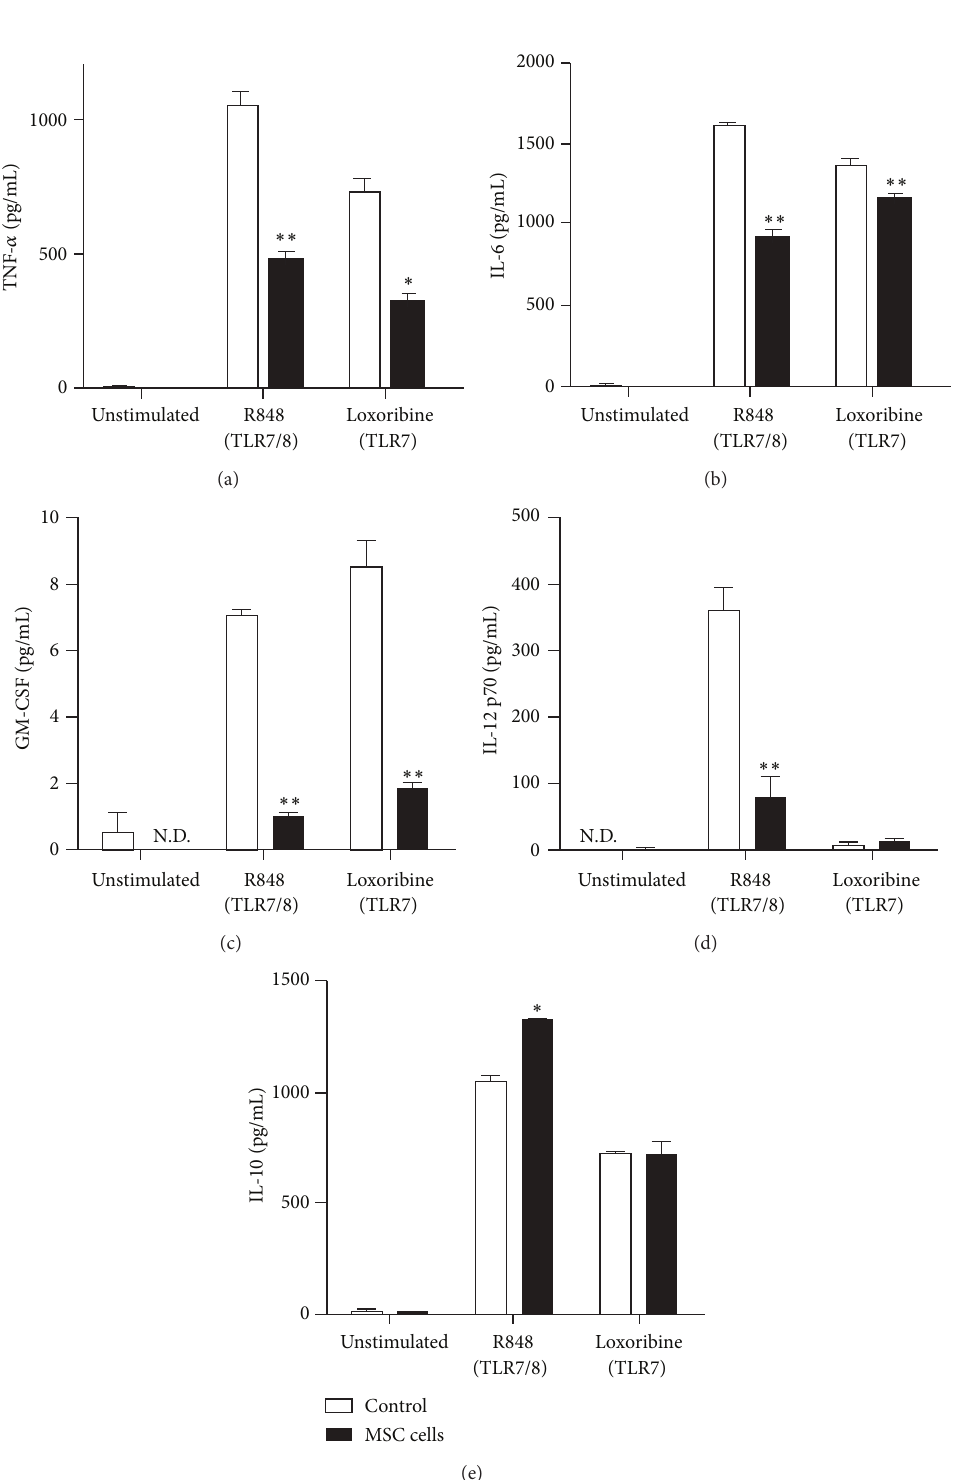
Figure 1: Modulation of cytokine expression by BMDMs cocultured with MSCs and then stimulated with TLR7/8 ligands. BMDMs (0.4 × 10 6 cells/well) were incubated with or without MSCs (0.4 × 10 6 cells/well) in 24-well plates. After 1h, the cells were incubated with R848 (TLR7/8 ligand, 10 𝜇 g/mL) or loxoribine (TLR7 ligand, 300 𝜇 g/mL) for 24 h. The levels of murine TNF- 𝛼 , IL-6, GM-CSF, IL-12 p70, and IL- 10 in the culture supernatant were determined using ELISA. Data are expressed as the mean ± SEM. 𝑛 = 3 in each group. ∗ 𝑃 < 0.05 and ∗∗ 𝑃 < 0.01 , compared to the control group. N.D., not detected. Results are representative of 3 independent